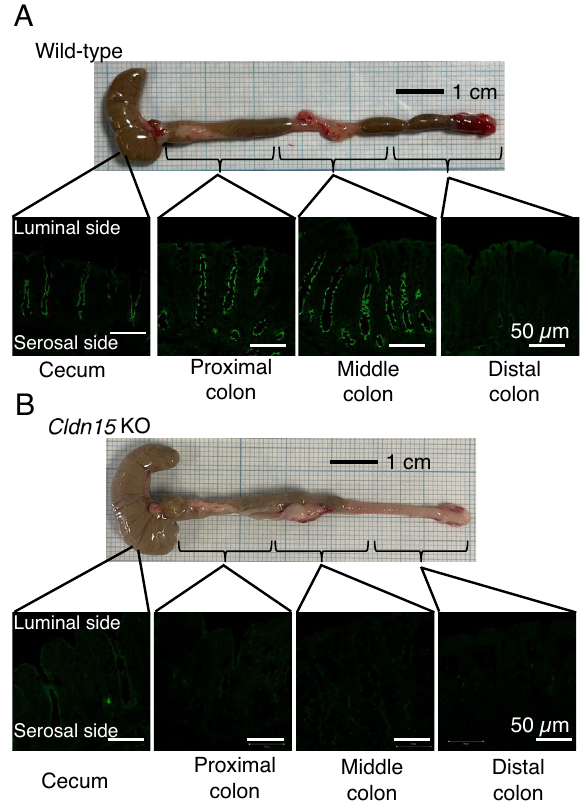
Figure 1. Claudin-15 expression in the cecum and large intestine. Representative immunofluorescence images showing claudin-15 (green) antibody staining in the cecum, proximal, middle, and distal large intestine of WT mice ( A ) and Cldn15 KO mice ( B ). Scale bar, 50